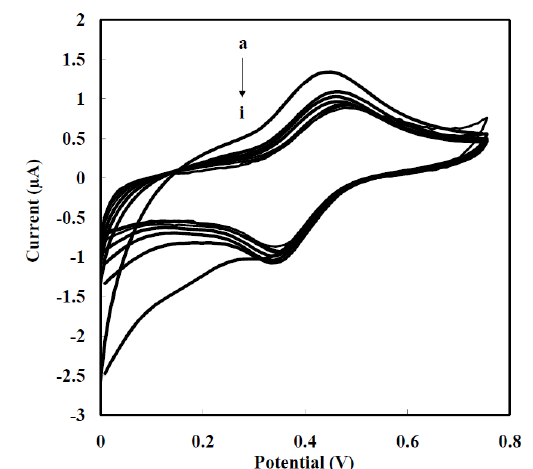
Figure 4. Cyclic voltammograms Cu-complex/MWCNTs/GCE in solution for different pH values (a=3, b=4, c=5, d=6, e=7, f=8, g=9, h=10 and i=11) scan rate 10 mV s -1 .